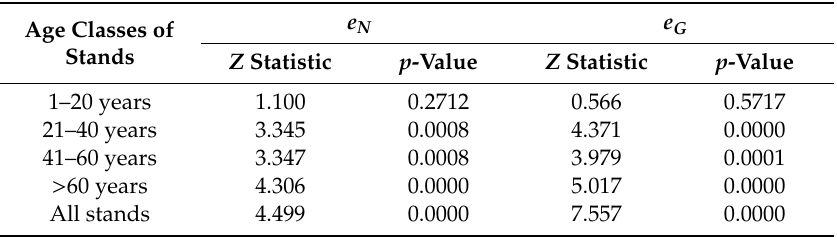
Table 6. Results of the Wilcoxon signed-rank test for comparison of error indexes e N and e G for Weibull and percentile diameter distribution